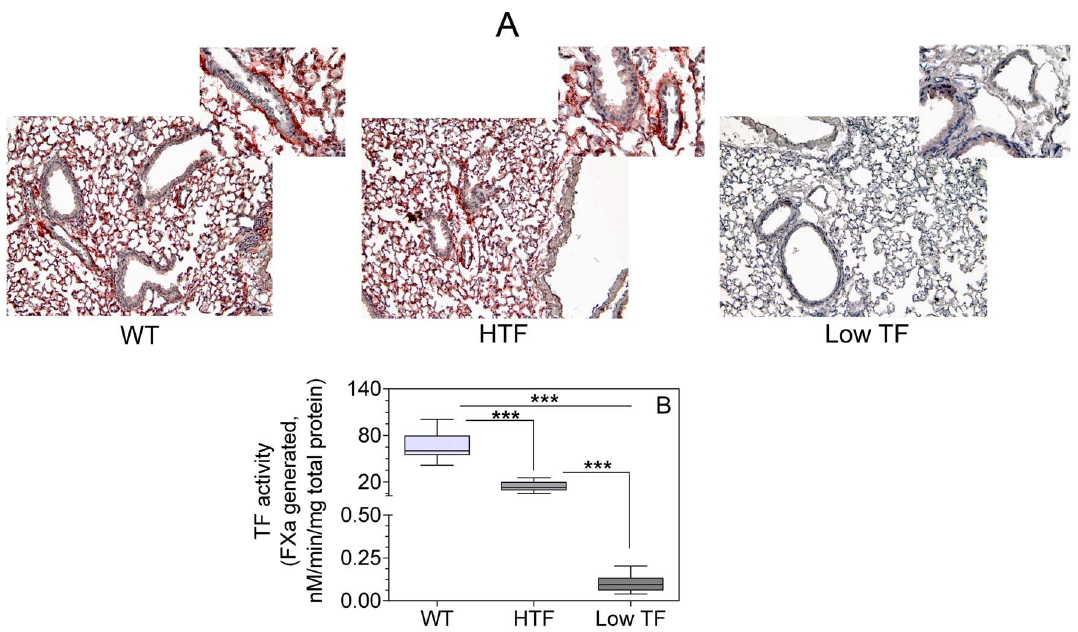
Figure 1. Tissue factor expression levels in wild-type (WT), HTF and low TF mice. ( A ) Immunohistochemical analysis of TF expression in WT, HTF, and low TF mice. Representative images (magnification, 10 6 ; inset, 40 6 ) are shown. TF immunohistochemical staining was performed using anti-murine TF antibodies for WT mice and anti-human TF antibodies for HTF and low TF mice. ( B ) TF activity of total lung homogenates of WT, HTF, and low TF mice. TF activity was measured in FX activation assay using species-specific FVIIa. (n 5 9–14 per group). *** denotes p , 0.0001 as determined by one-way ANOVA and student t-test.